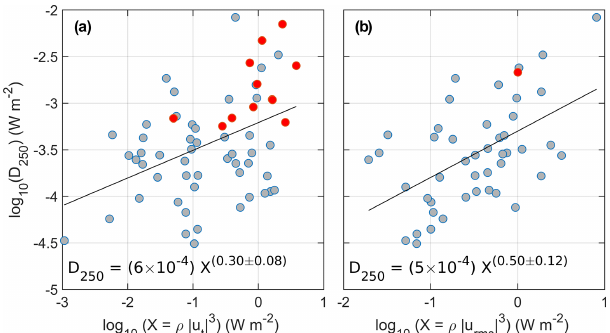
Figure 8. Depth-integrated dissipation rate in the bottom 250m ( D 250 ) regressed against (a) the instantaneous tidally driven bottom drag and (b) the typical tidally driven bottom drag (using u rms ). See text for details. Linear fits on the logarithmic parameter space (i.e., power-law fits) denoted by the black lines, and the corresponding equations are indicated with the 95% confidence levels. Red dots are the data points from the RS2 station. Process stations are batch- averaged (in sets of 4–5 consecutive profiles) in (a) and averaged over the station duration in (b)